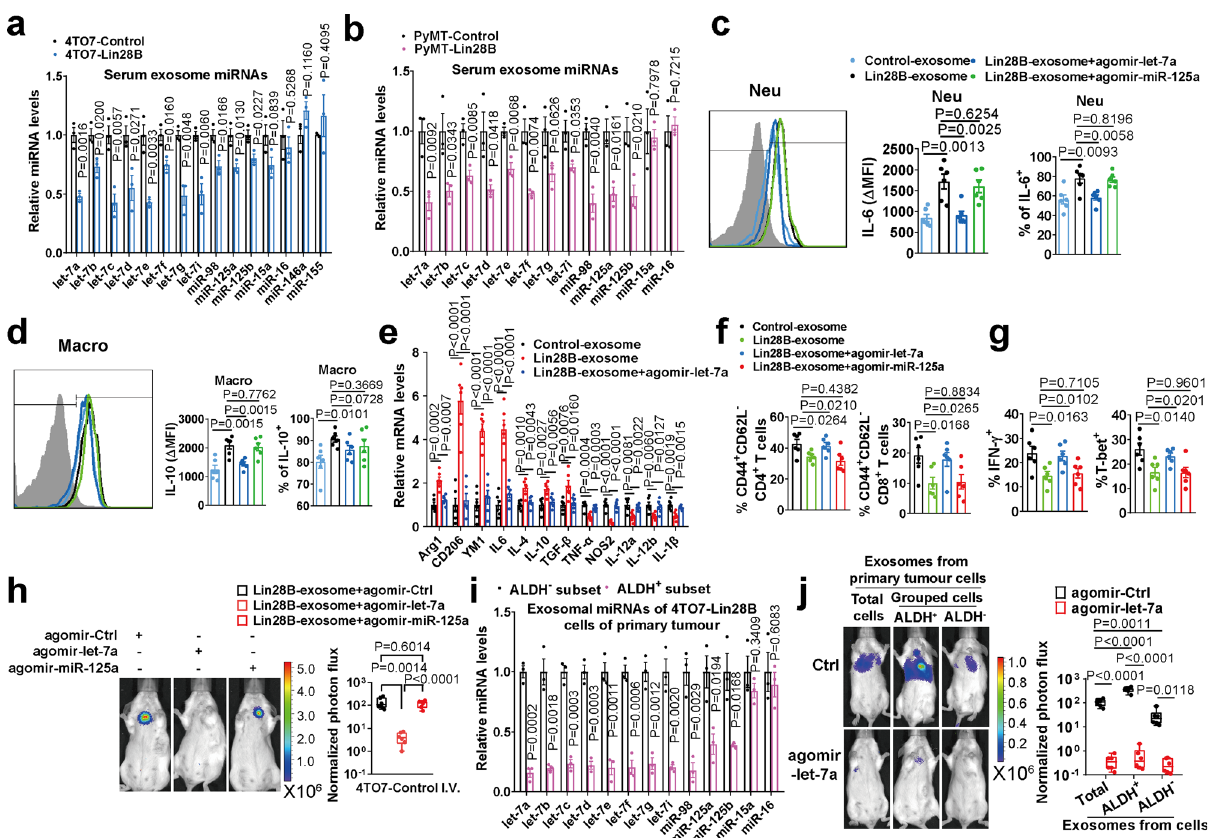
Fig. 7 Decreased exosomal let-7s are responsible for immunosuppressive niche establishment. a Let-7s and miR-125s family members were specially reduced in the circulation exosomes in mice bearing 4TO7-Lin28B tumor ( n = 3 mice in each group). b The experiment was the same as in panel a , except that let-7s and miR-125s family members were measured in the serum exosomes of PyMT mice (11-week old) ( n = 3 mice in each group). c Let-7a inhibited increased production of IL-6 in neutrophils mediated by Lin28B-exosome. Naïve mice were i.v injected with Control-exosome or Lin28B-exosome in the presence of the indicated agomir. IL-6 expression was determined in lung neutrophils by FACS ( n = 6 mice in each group). d The experiment was the same as for panel c , except that the IL-10 was detected in macrophages ( n = 6 mice in each group). e Let-7a inhibited neutrophil N2 conversion induced by Lin28B-exosomes. The exosome treatment was the same as for panel c. GAPDH served as an internal control ( n = 6 mice in each group). f Let-7a rescued T cell inactivation induced by Lin28B-exosome ( n = 6 mice in each group). g Let-7a restored Lin28B-exosome-mediated inhibitory Th1 differentiation of CD4 + T cells ( n = 6 mice in each group). h Let-7a attenuated Lin28B-exosome-mediated lung metastasis ( n = 6 mice in each group). i ALDH + and ALDH − subsets of 4TO7-Lin28B cells isolated from primary tumors were analyzed for exosomal miRNA expression. U6 served as an internal control ( n = 3 mice in each group). j The ALDH + and ALDH − subset exosomes were collected as for panel i , and the exosome education and the I.V. injection of tumor cells were the same as in Fig. 6c. Shown are images and BLI quanti fi cation of lung metastasis of 4TO7-Control cells ( n = 6 mice in each group). Data were presented as the mean ± SEM, and p values were calculated using a two-tailed Student ’ s t -test. For panels ( h ) and ( j ), boxes represent data within the 25th to 75th percentiles. Whiskers depict the range of all data points. Horizontal lines within boxes represent mean values. * p < 0.05, ** p < 0.01, *** p < 0.001, ns no signi fi cance. Source data are provided as a Source Data fi